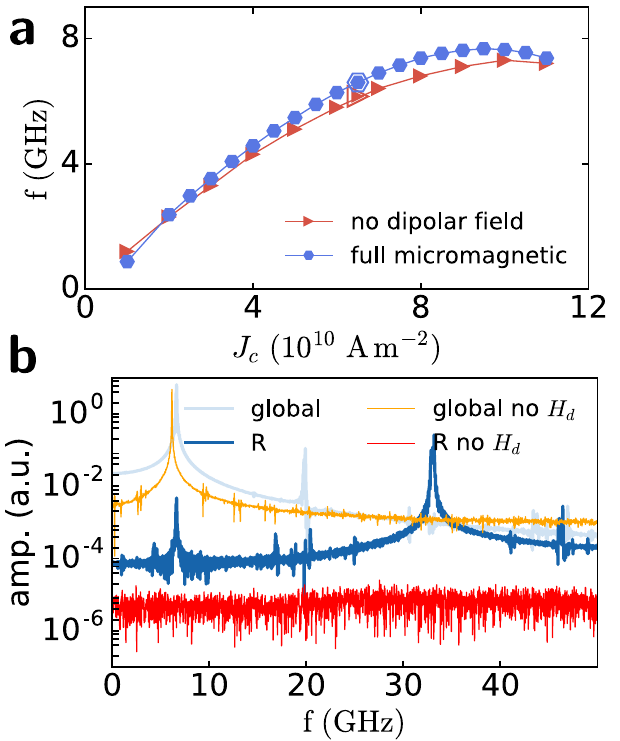
Figure 7. Role of non-local stray field in exciting SWs. ( a ) DW rotation frequency as a function of current for full micromagnetic simulations (blue hexagons) compared with simulations without the non-local effect of the magnetostatic field (orange triangles). ( b ) Fourier transform of m t ( ) averaged over the whole sample and in the x region R 400 nm from the notch, as in Fig. 2a (light and dark blue lines), under the application of . × − 6 5 10 Am 10 2 . Simulations without computation of the dipolar fields (orange and red lines) show a single peak at the DW frequency and no signal away from the DW.